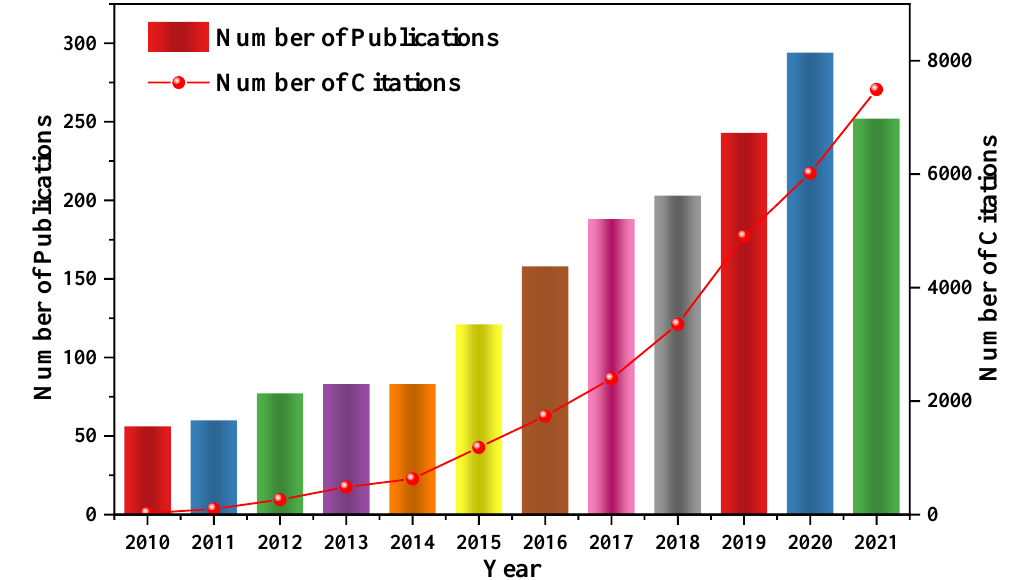
Figure 2. Number of publications and citations from 2010 to 2021.